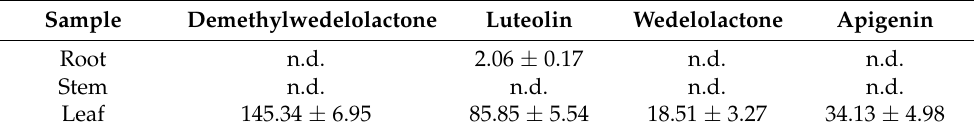
Table 2. Quantitative analysis of 4 metabolites ( μ g/g dry weight) in different tissues from diploid wild-type Wedelia chinensis .